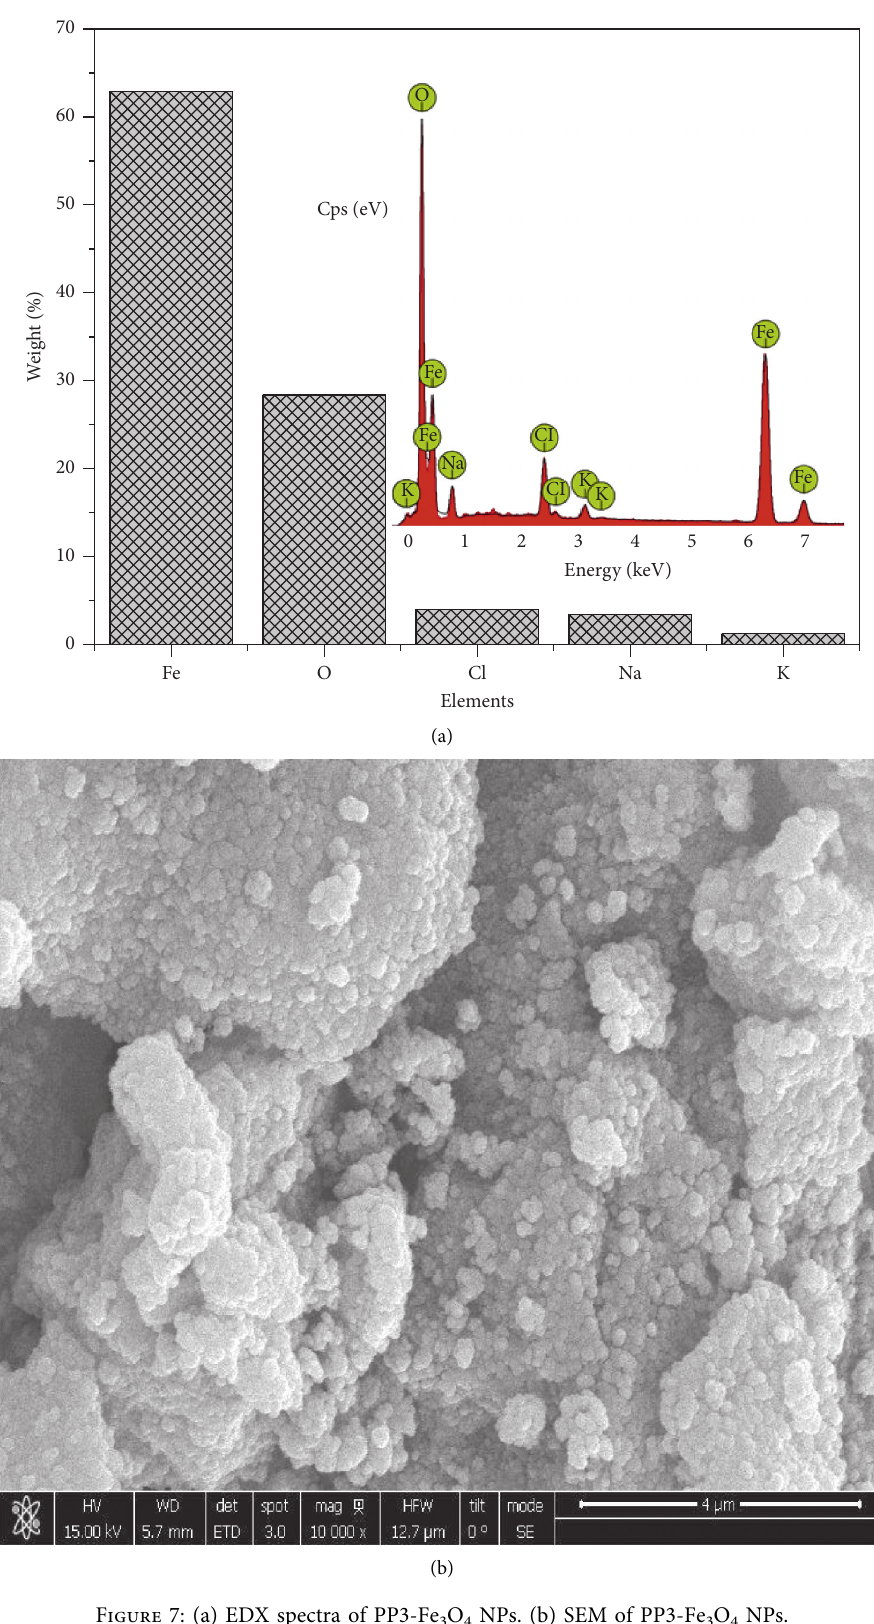
Figure 7: (a) EDX spectra of PP3-Fe 3 O 4 NPs. (b) SEM of PP3-Fe 3 O 4